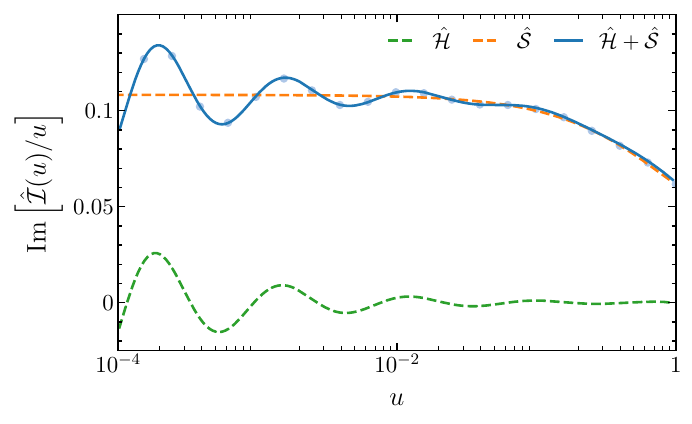
Figure 3 . The analytical solution of the primary scalar seed with µ = 3 . For comparison, the blue dots are numerical results from the direct integration of